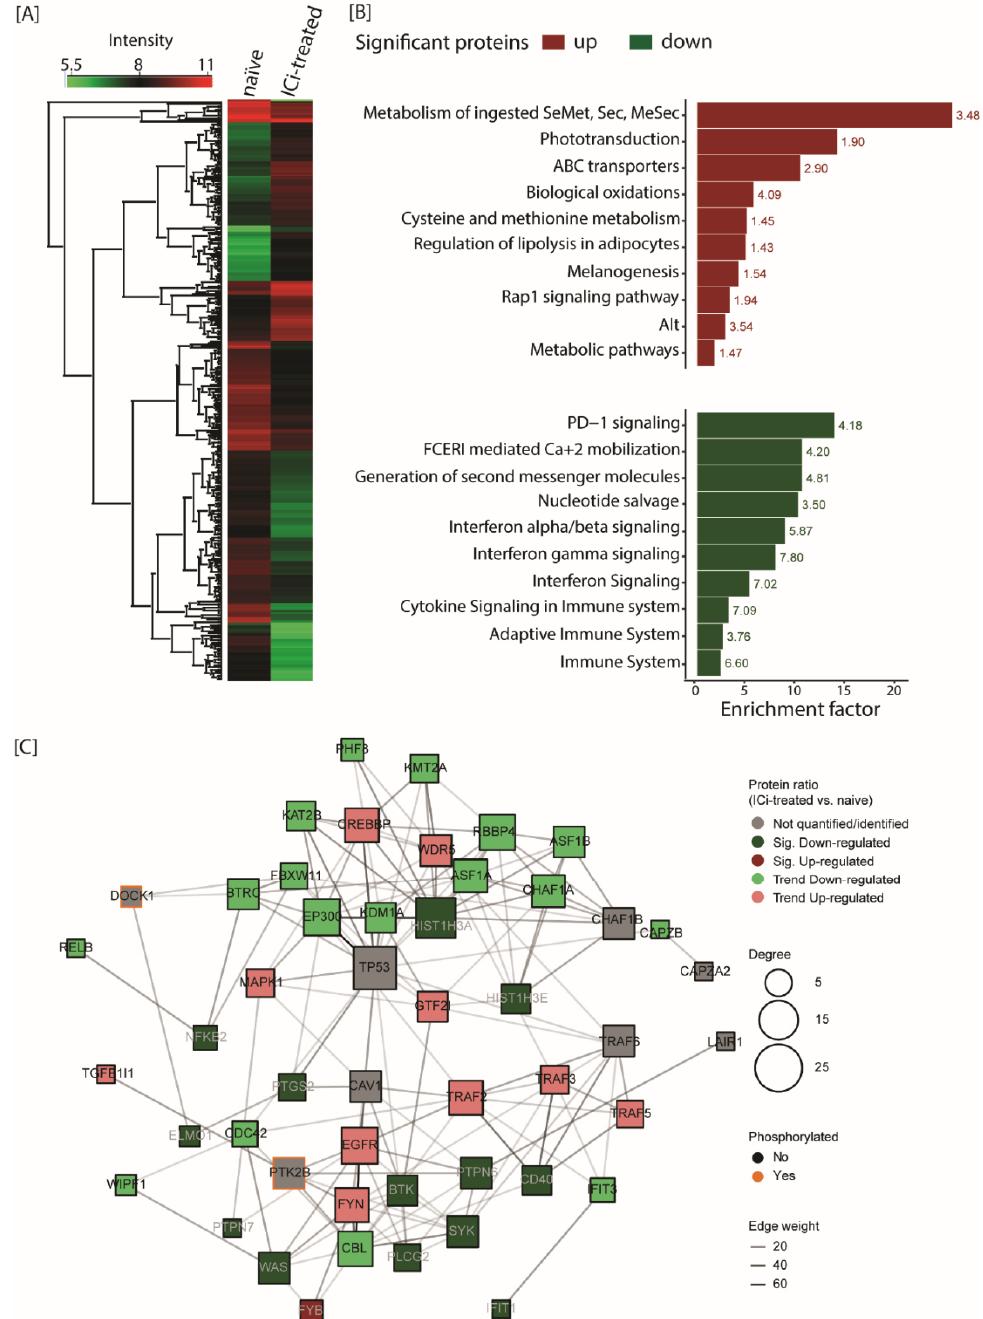
Figure 4. Differential protein expression between naïve and ICi-treated patients. ( A ) Heat map of significantly regulated proteins between naïve and ICi-treated patients (Sig. B, FDR ≤ 0.05). Color code depicts log 10 -transformed IBAQ intensities of proteins for each group. ( B ) Pathway over-representation of significantly regulated proteins between naïve and ICi- treated patients (Sig. B with FDR ≤ 0.05; Fisher-Exact test with FDR ≤ 0.02). Pathways over-represented based on up- and down-regulated proteins are displayed in red and green, respectively. The text on the right of each bar corresponds to the over-representation of the − log 10 p -value. ( C ) Interaction network of immune related proteins significantly changed be- tween ICi-treated and naïve patients, as well as their direct protein interactors. Only the top 50 entries are displayed (ranked based on their interaction degree). Entries are colored based on their direction of regulation between ICi-treated and naïve patients; i.e., not quantified (grey), down-regulation trend (light green), significant down-regulation (dark green), up-regulation trend (light red) and significant up-regulation (dark red). Entries that were also found to be phos- phorylated are displayed with an orange stroke. Node size is proportional to the node number of connections (degree).